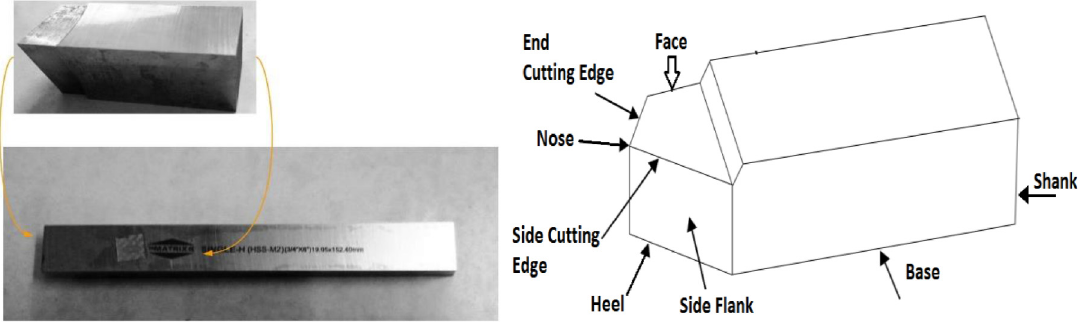
Fig. 4. M2 HSS tool before and after pro fi le grinding. Table 1. Chemical composition of AISI M2 HSS tool.